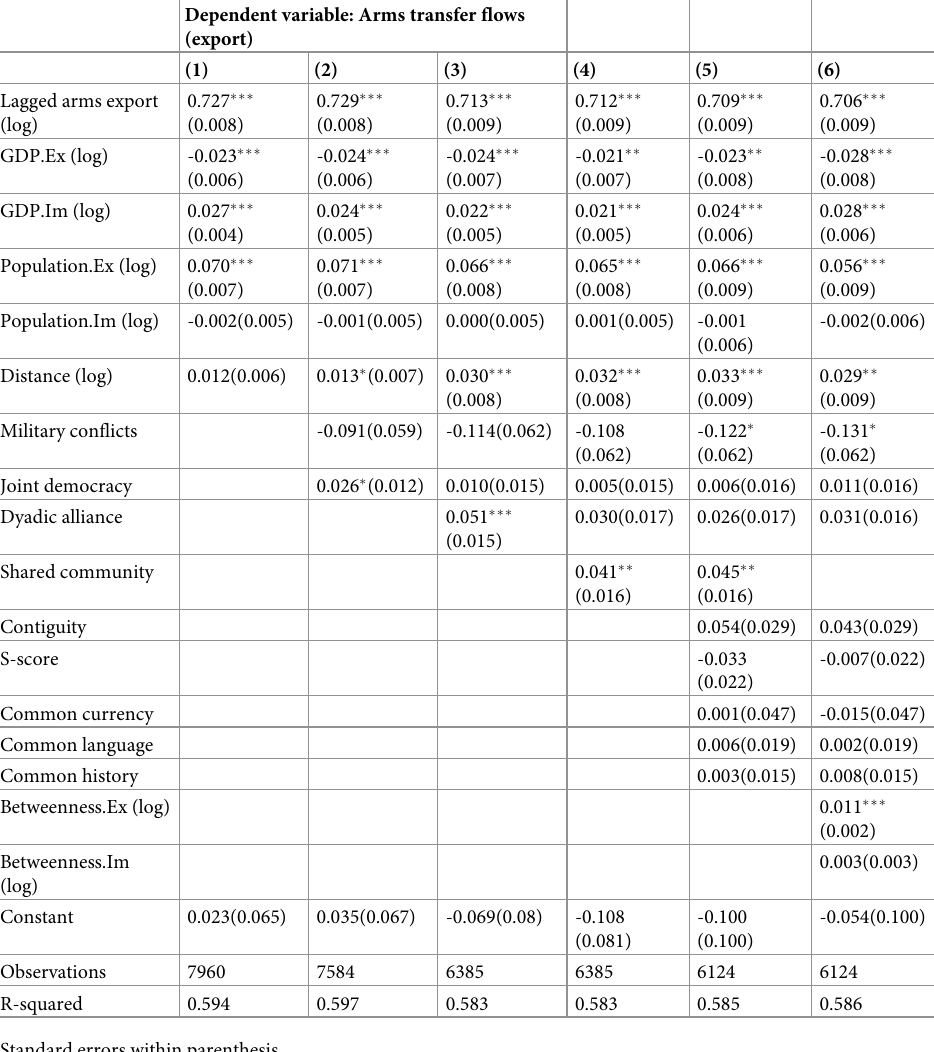
Table 6. Estimation